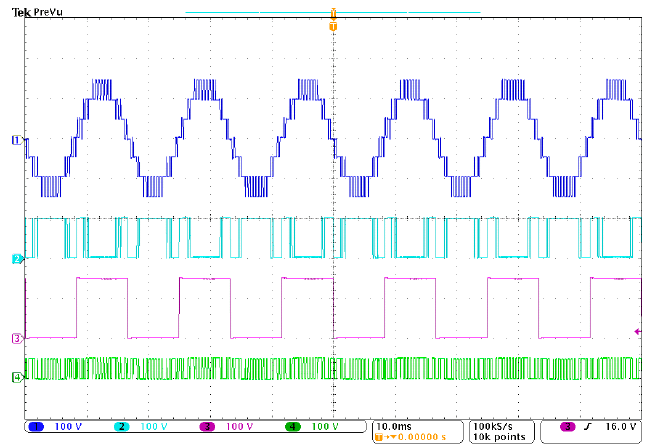
Figure 5. MPUC inverter switches’ voltage ratings. Ch 1 : V ab , Ch 2 : T 1 voltage, Ch 3 : T 2 voltage, Ch 4 : T 3 voltage.